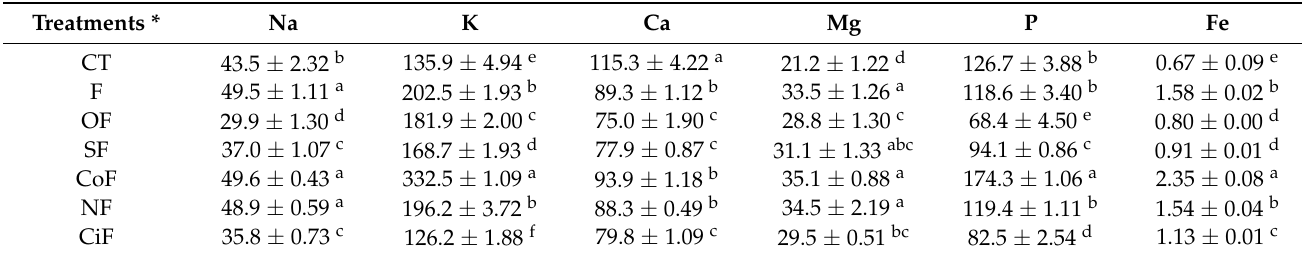
* Refer to Materials and Methods for details. Data are expressed as Mean ± SE. Different superscripts letters (a, b, c, d, e and f) indicate statistical significance between different treatments using chufa milk and other flavoring materials. Means within the same column with different superscripts differ at p ≤